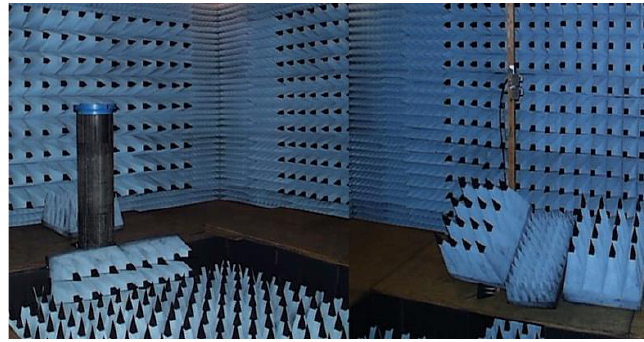
Figure 3. Measurement station in an anechoic chamber.